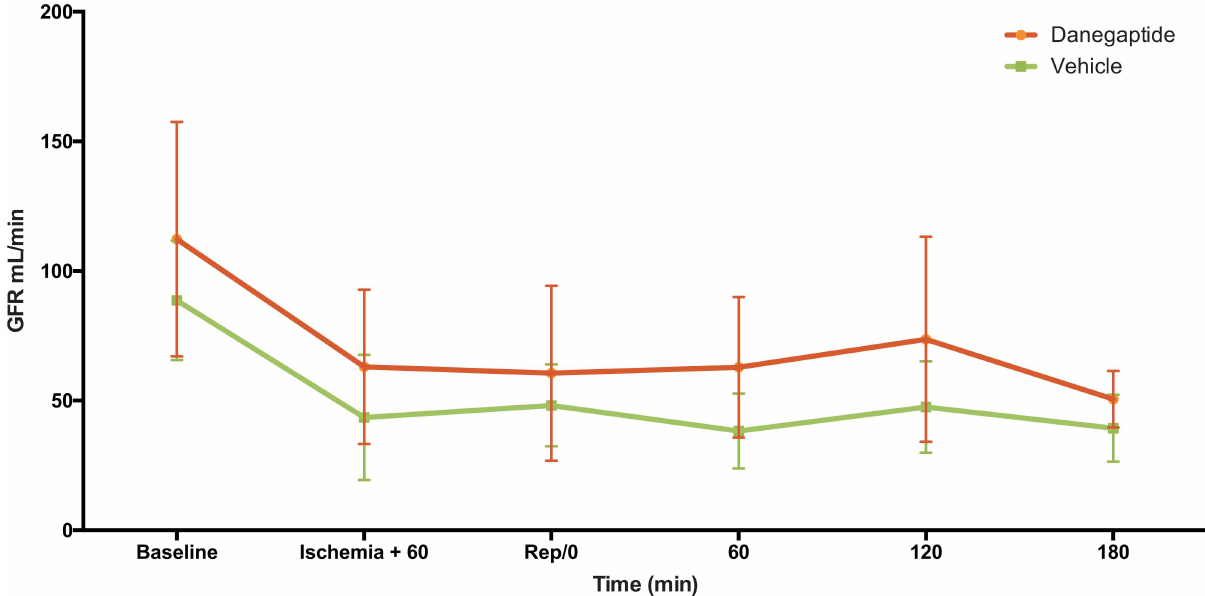
Fig 2. GFR day 1- GFR measured by 51 Cr-EDTA clearance. Error bars represents 95% CI.